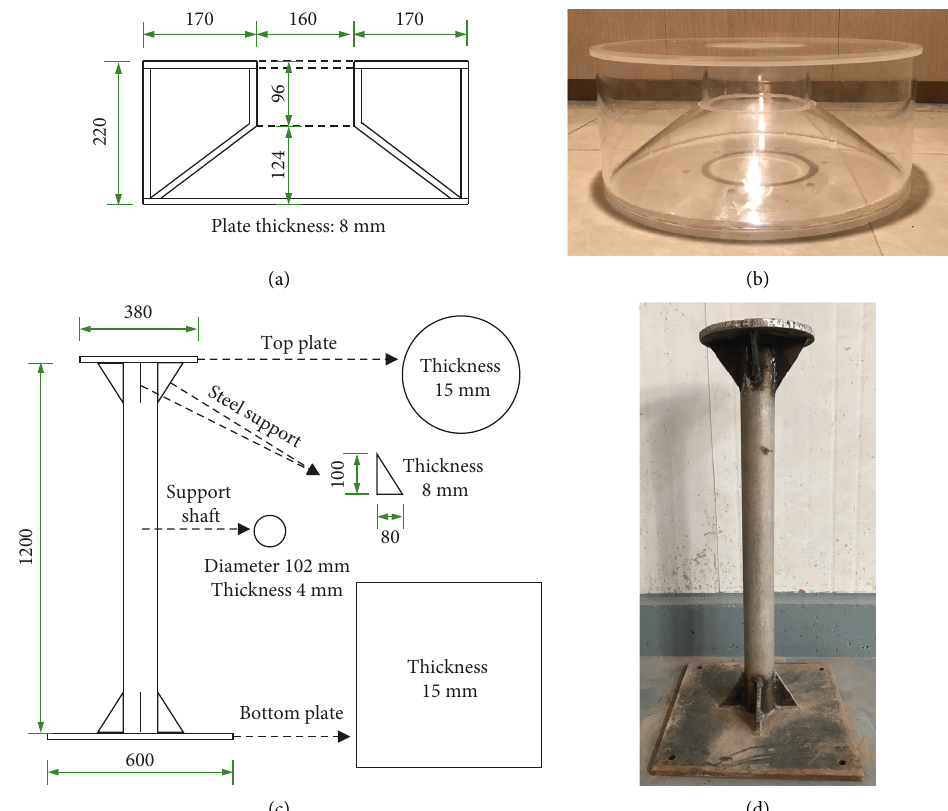
Figure 2: Experimental model and specific sizes. (a) Dimensions of water tank. (b) Water tank model. (c) Dimensions of lower structure. (d) Lower model.